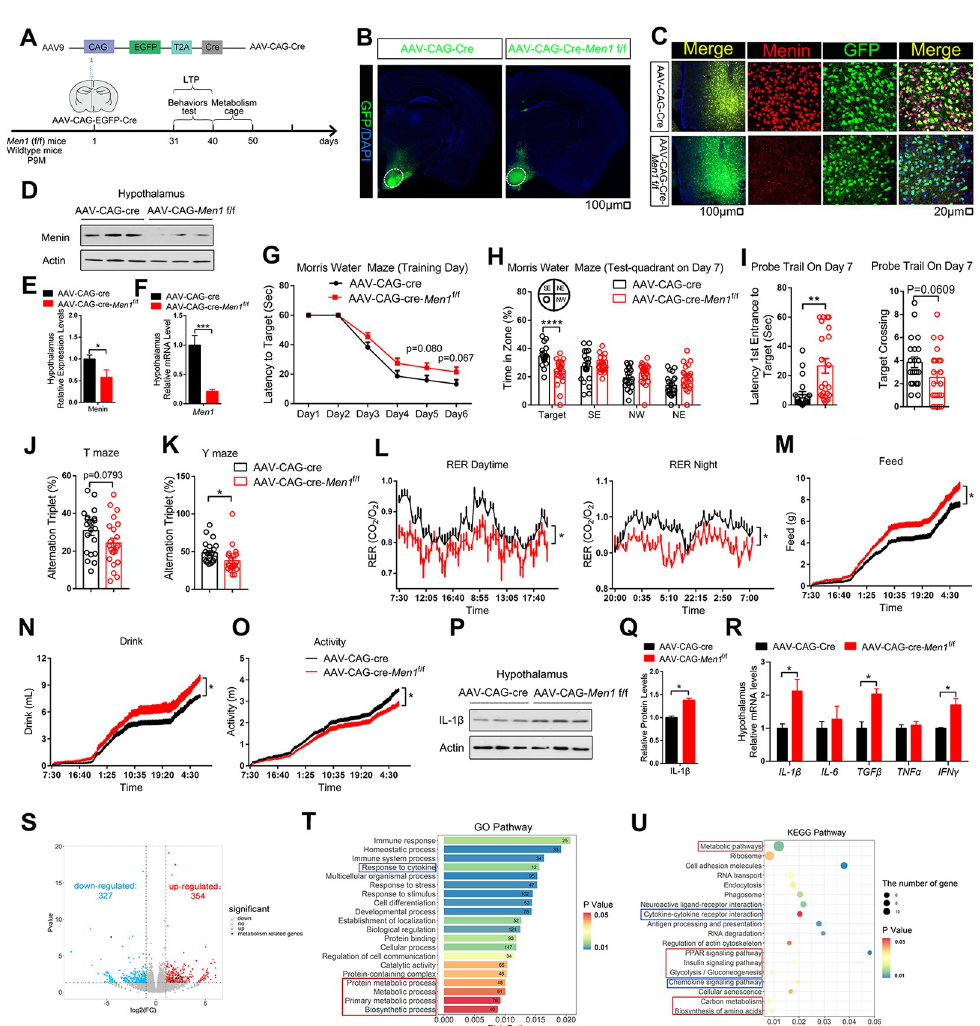
Fig 2. Menin knockdown virus in VMH leads to deficient spatial memory and metabolic disorder. (A) Schematic diagram of knockdown of Men1 by injection of Cre-dependent CAG-GFP-AAV in VMH of Men1 f/f mice and control mice (injection at 9M) that are defined as AAV-CAG-Cre and AV-CAG-Cre- Men1 f/f . (B) AAV-GFP immunofluorescence staining in mouse hypothalamus following AAV injection. Scale bar, 100 μ m. (C) Representative hypothalamus brain sections from 10 months male AAV-CAG-Cre–injected WT mice and AAV-CAG-Cre–injected Men1 f/f mice stained with Menin (red) and GFP (green) antibody. Section was counterstained with DAPI (blue). Scale bar, 100 μ m, 20 μ m. (D–F) The protein and mRNA levels of Menin in the hypothalamus from 10 months old AAV-CAG-Cre–injected WT and Men1 f/f mice; n = 3 mice. (G–K) Morris water maze (G–I), T maze (J) and Y maze (K) tests were performed in 10 months male AAV-CAG-Cre–injected WT and Men1 f/f mice (AAV-CAG-Cre/AAV-CAG-Cre- Men1 f/f ). During Morris water maze tests, 10 months male AAV-CAG-Cre–injected WT and Men1 f/f mice were analyzed for escape latency during a 6-day training period (G). On the next day, mice were analyzed for time spent in the target zone and other quadrants (northeast, southeast, and northwest) (H), number of target crossings and time required from entrance to the target platform (I). (L) Day and night respiratory quotients (RER) of 10 months male AAV-CAG-Cre mice and age-matched AAV-CAG-Cre- Men1 f/f mice were measured. Exact dietary (M), water intake (N), and activity (O) were also measured. (P–R) Inflammatory factors protein expression and mRNA levels in the hypothalamus of 10 months male AAV-CAG-Cre mice and AAV-CAG-Cre- Men1 f/f mice; n = 3 mice. (S–U) DEGs were identified from the hypothalamus of 13 months male ScKO mice and control mice and were shown in panel S. DEGs then were analyzed by GO pathway (T) and KEGG pathway (U). The red box represents the enriched metabolic pathway. The blue box represents the enriched cytokine pathway; n = 3 mice. Mouse number used in measuring energy expenditure by open circuit indirect calorimetry: AAV-CAG-Cre mice: n = 8 mice; AAV-CAG-Cre- Men1 f/f mice: n = 8 mice. Mouse number used in behavior tests: AAV-CAG-Cre mice: n = 21 mice; AAV-CAG-Cre- Men1 f/f mice: n = 22 mice. Data represent mean ± SEM, n.s.: not significant, � p < 0.05, �� p < 0.01, ��� p < 0.001. Unpaired t test for behavioral statistics. Statistical applications between groups across multiple time points were analyzed by repeated-measures ANOVA. Other statistical applications were analyzed by one-way ANOVA